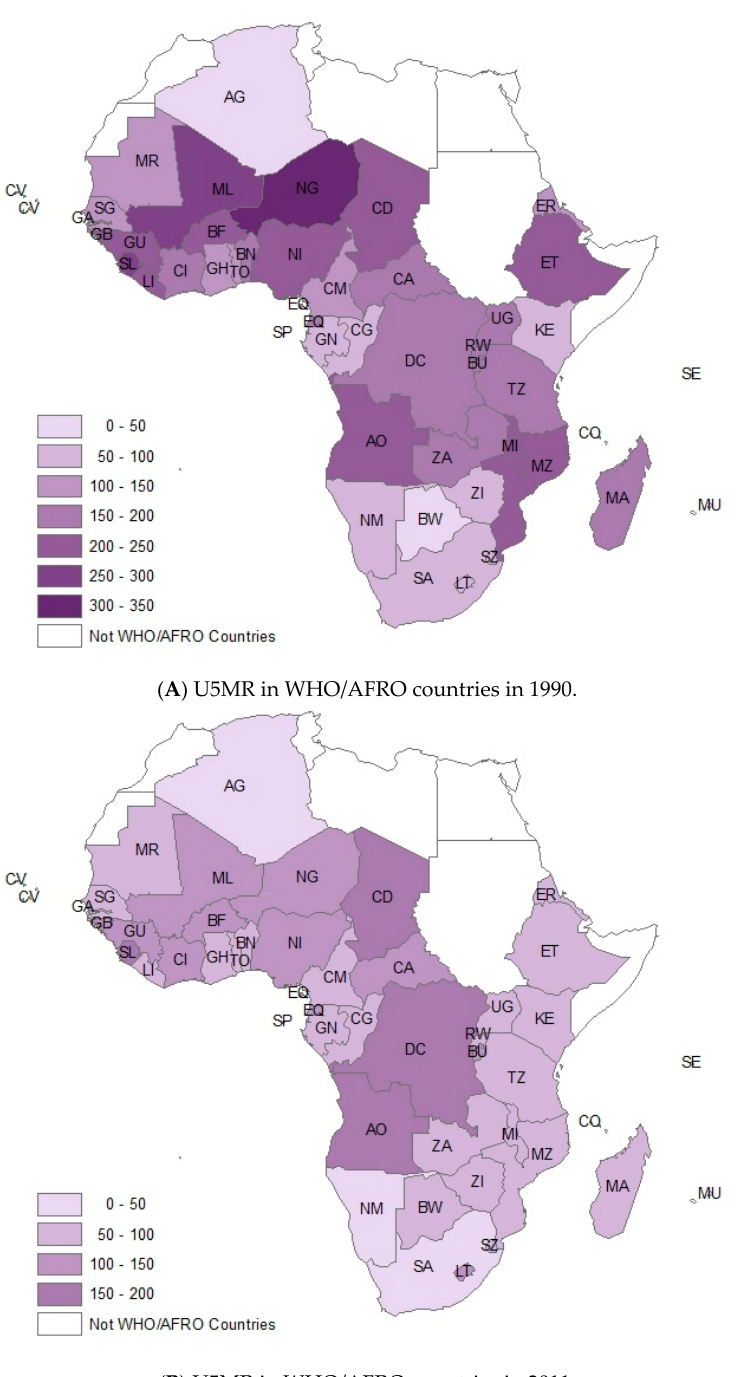
Figure 5. Comparing the variation of U5MR of Africa Countries, ( A ) 1990 and ( B ) 2011, by GIS. This figure showed the variation of U5MR by GIS.